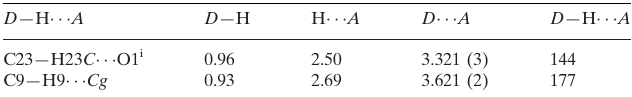
Hydrogen-bond geometry (A˚ , (cid:2)